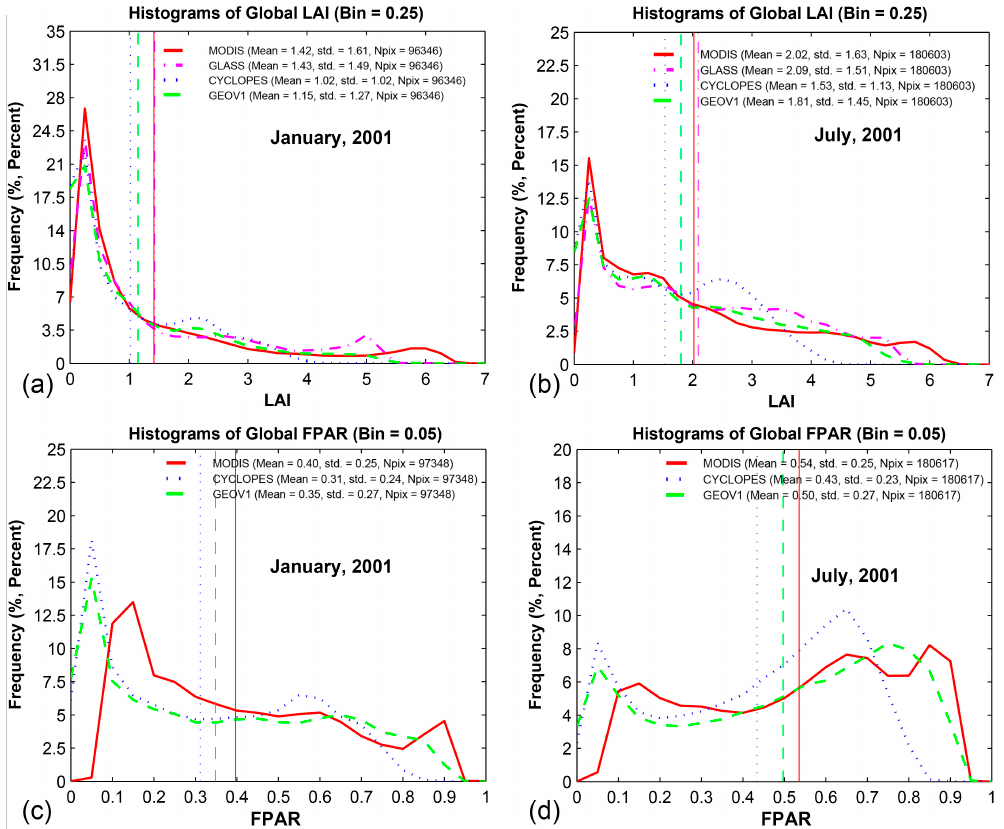
Figure 4. Histograms of global LAI ( a , b ) and FPAR values ( c , d ) from four products analyzed in this study during the months of January and July of 2001. The frequency is given as the percentage of the total number of global vegetated pixels. Global mean LAI values are depicted by vertical lines. The bins used for LAI and FPAR are 0.25 and 0.05, respectively.